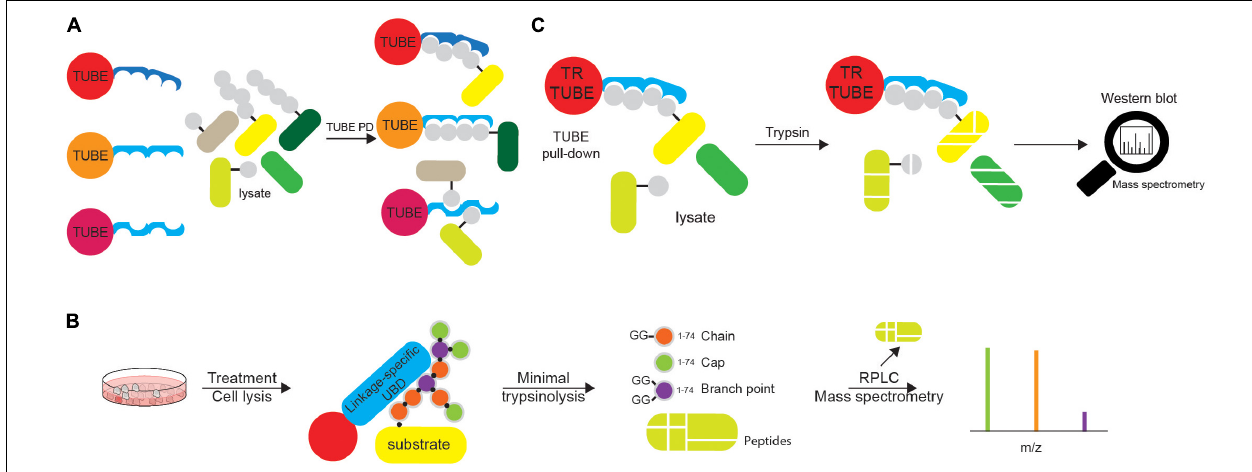
FIGURE 7 | Tandems of ubiquitin entities can be utilized in various ubiquitin tools. (A) Tandems of Ub chain-specific or promiscuous UBDs, additionally equipped with affinity tags (such as FLAG-, HA-, GST-, or 6xHIS) and bound to appropriate resins, can be used for affinity purification of ubiquitinated proteins. The use of tandem UBDs increases affinity toward Ub due to avidity, as well as protects ubiquitinated proteins from endogenous DUBs during purification steps. Purified ubiquitinated proteins can be further analyzed by either Western blotting or MS. (B) Ub chain enrichment middle-down MS (UbiChEM-MS) approach is based on the enrichment of the specific Ub linkages by linkage-specific UBDs or antibodies, combined with minimal trypsinolysis of Ub that induces a single Ub cleavage after Arg74 and leaves the rest of the Ub molecule intact. By using that approach, Ub molecules within chain, as well as capping and branched Ub conjugates can be detected and quantified by MS. (C) Ub-ProT (Ub chain protection from trypsinization) method determines the length of Ub chains bound to target proteins. Trypsin-resistant (TR)-TUBE (i.e., PLIC1 UBA domain lacking Arg residues) is used for the enrichment of ubiquitinated proteins that can be analyzed by Western blotting. Furthermore, since TR-TUBE-protected sample is resistant to trypsin digestion, it can be applied for the determination of the length of Ub chains by quantitative